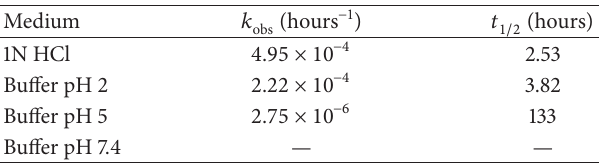
Table 2: First-order hydrolysis plot of atenolol ProD 1 in (a) 1N HCl, (b) buffer pH 2, and (c) buffer pH